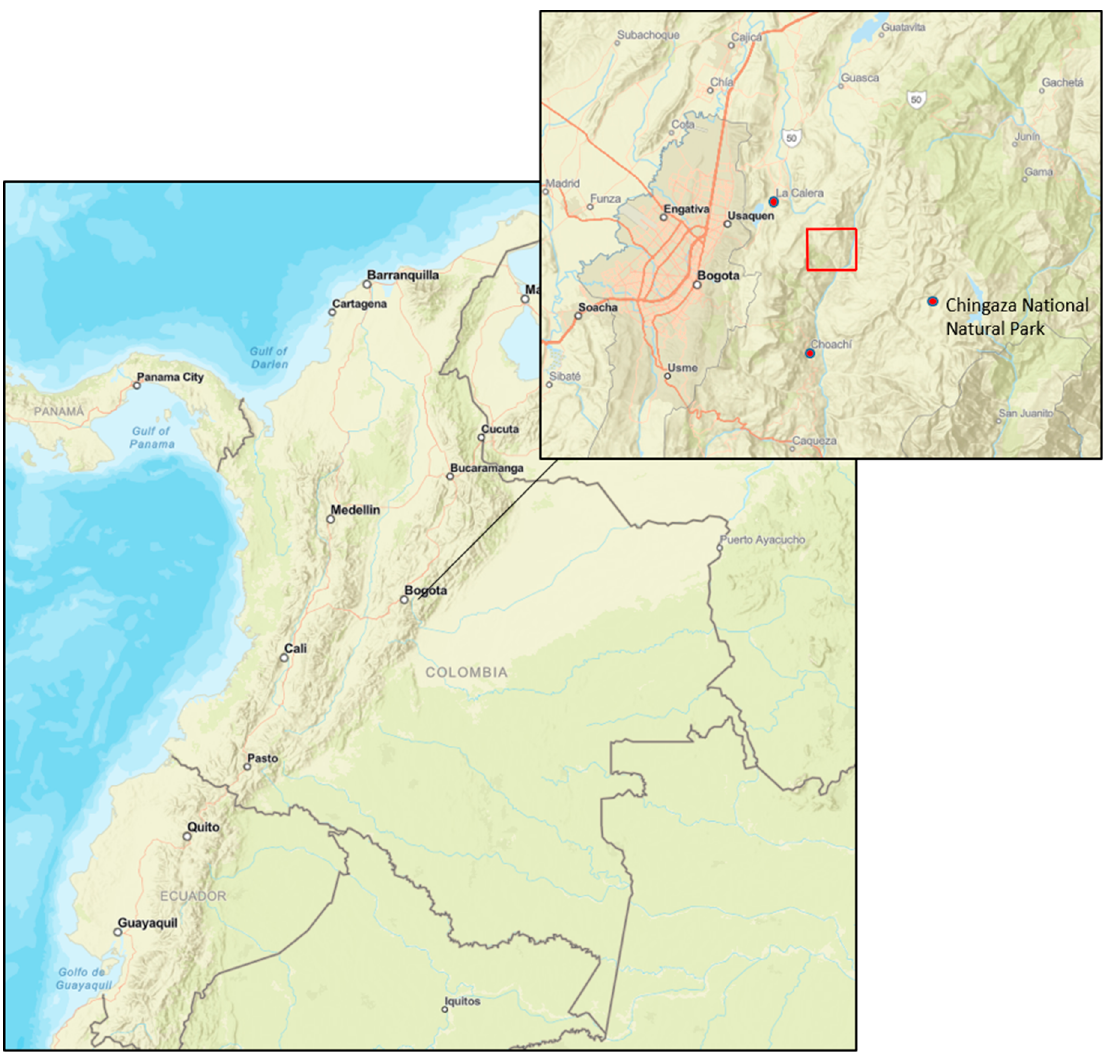
Figure 2. Location of field sites (in red) in Chingaza, Colombia (Adapted from) [33] (mapa digital de Colombia).